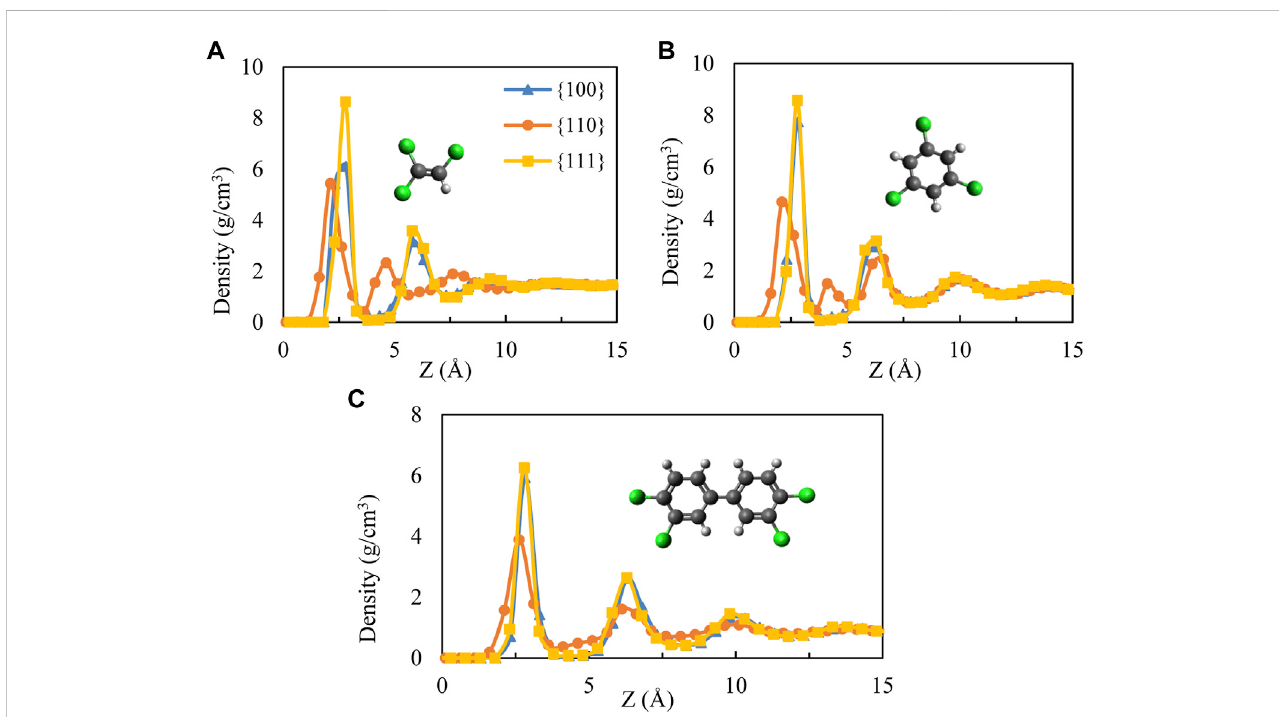
FIGURE 1 MassdensitydistributionasafunctionofdistancefromPdsurfacesfor (A) TCEat230 K, (B) TCBat360 Kand (C) PCB77at500 K.Thecartoonsshowthe molecular structures of the three organic contaminants studied. The TCB cartoon shows the molecule ’ s symmetrical isomer uniformly used in this study. Chloride, hydrogen, and carbon atoms are represented by green, white, and black,